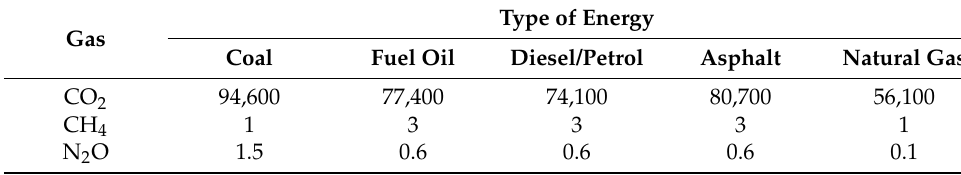
Table 5. Carbon emission factor (EF), (mg/MJ).